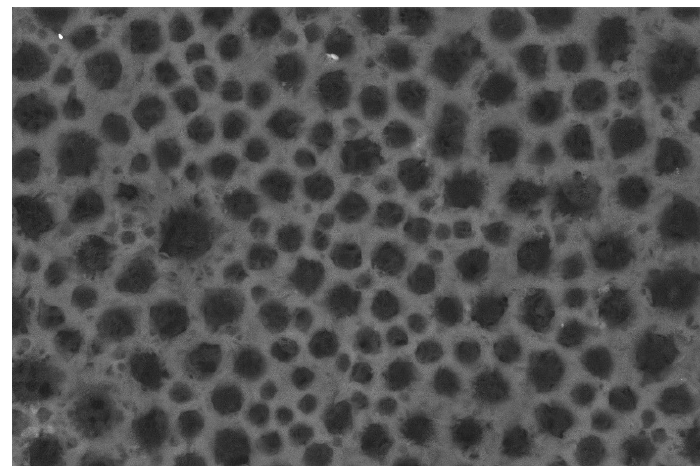
Figure 7. Synthesis of polymeric membranes with intrinsic microporosity.